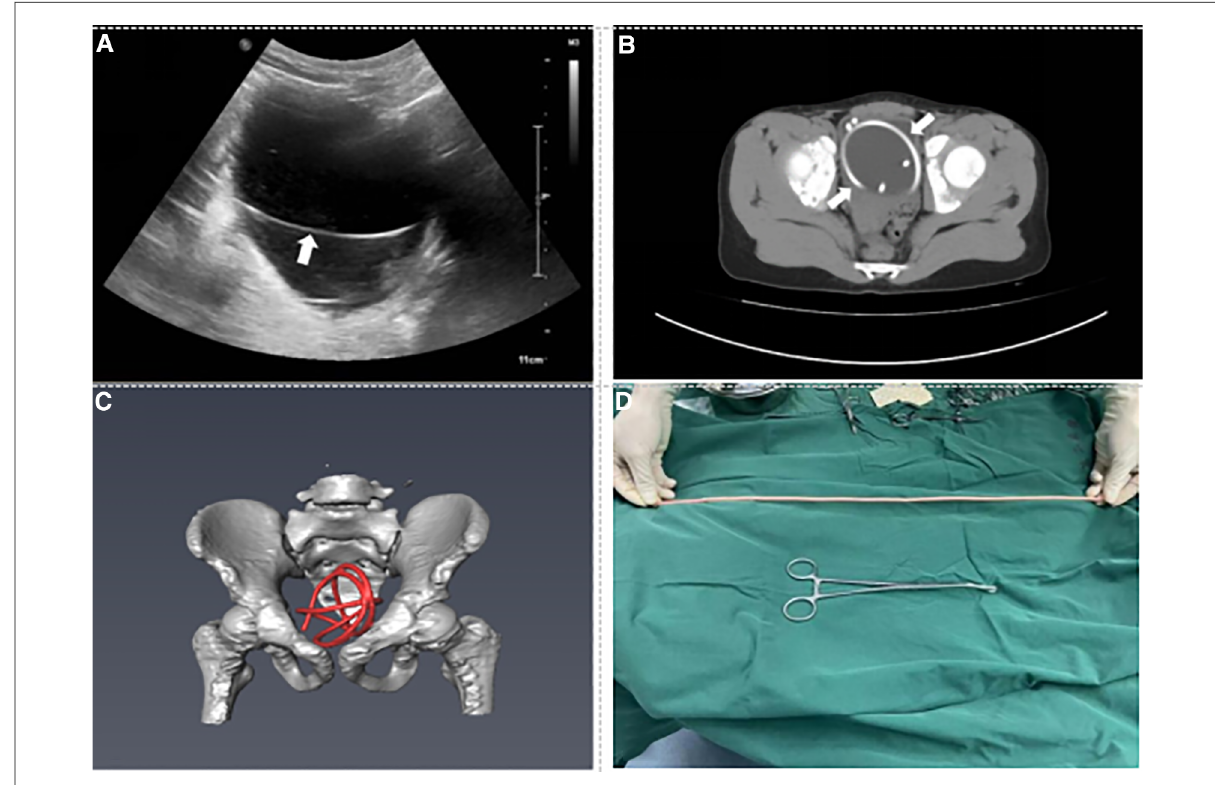
FIGURE 1 Preoperative imaging data and foreign body. ( A ) US shows the bladder foreign body (see arrow). ( B ) CT of the pelvis shows the crooked foreign body in the bladder (see arrow). ( C ) Three-dimensional reconstruction CT shows the lumpy foreign body in the bladder (red mark). ( D ) Foreign body is a skipping rope about 50 cm